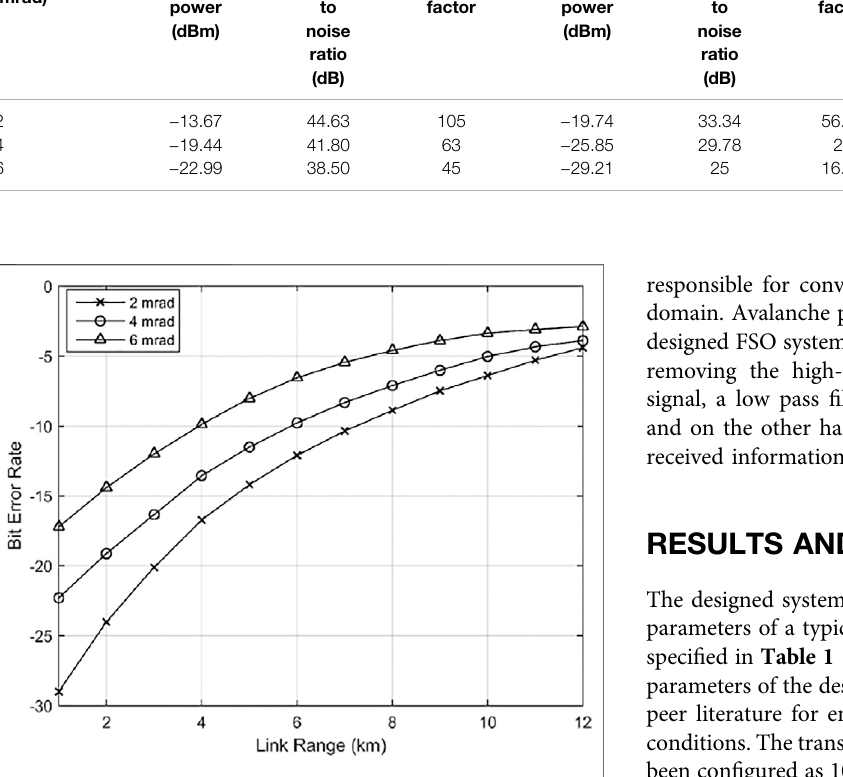
TABLE 2 | Analysis of performance characteristics of designed FSO system for different beam divergence scenarios. Beam divergence